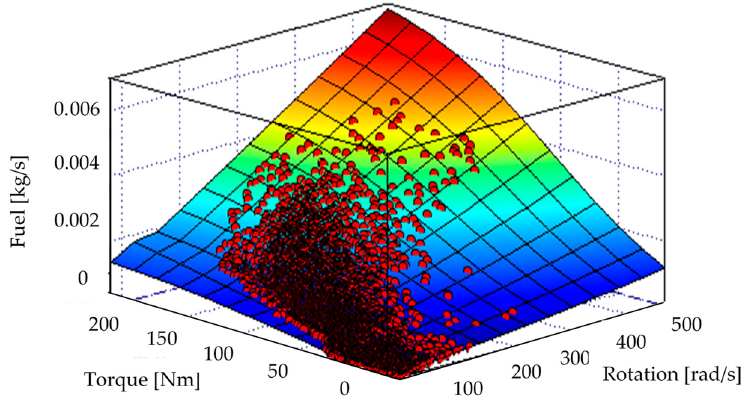
Figure 1. Measurement points of hourly fuel consumption as a function of engine rotational speed and engine torque, used to build the quantitative model [184].